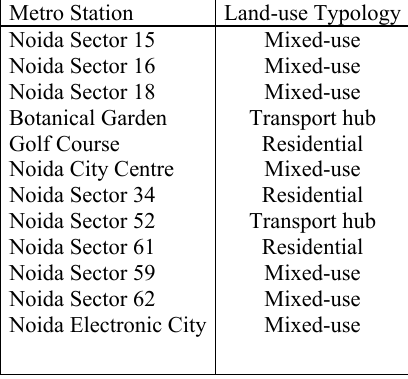
Table 2 . Metro Stations Land-use Typology